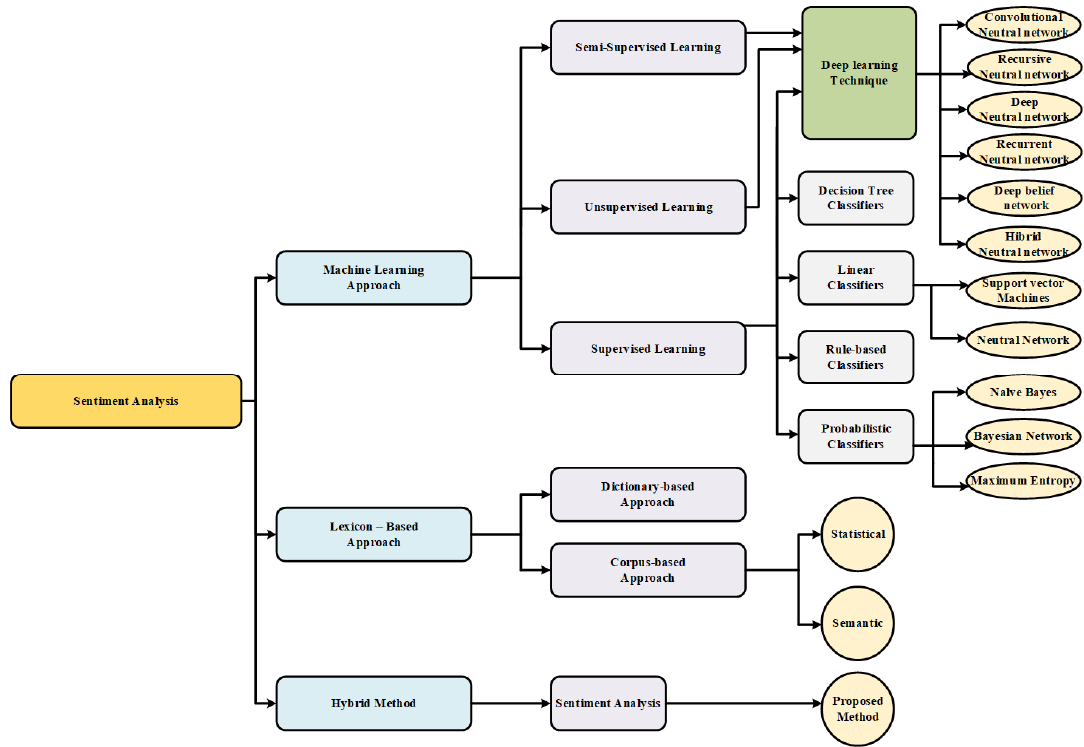
Figure 5. Taxonomy of sentiment analysis techniques. Source: [30,41] .